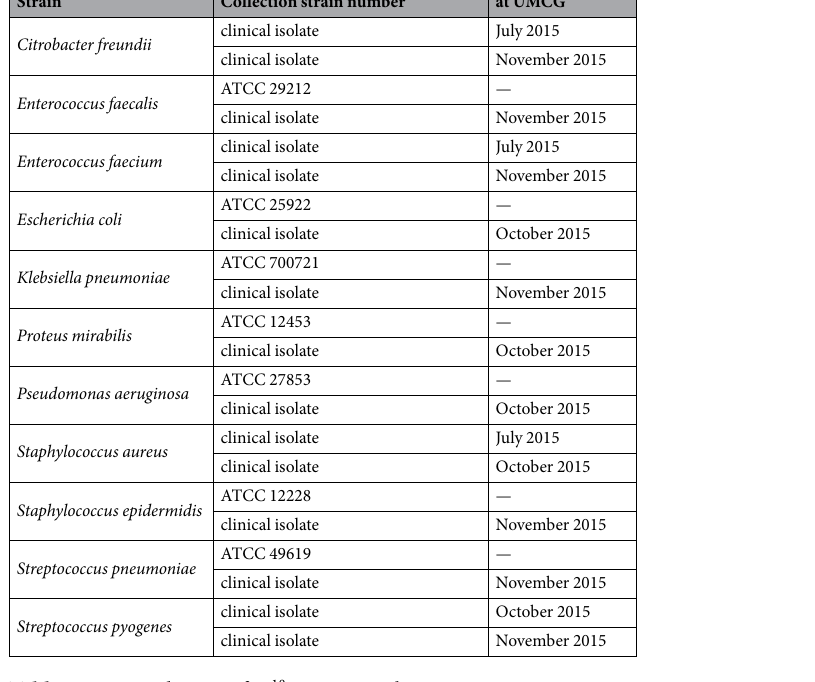
Table 1. Bacterial strains for 18 F-FDG uptake